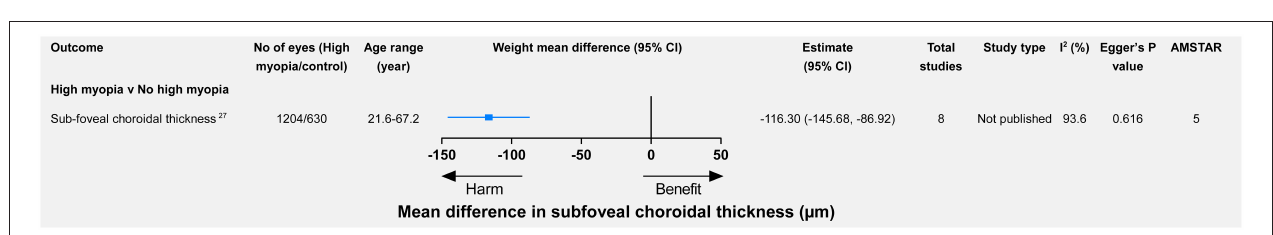
FIGURE 4 | High myopia vs. non-high myopia and changes (mean difference) in subfoveal choroidal thickness. association was found between cortical cataracts and mild, moderate, or high myopia